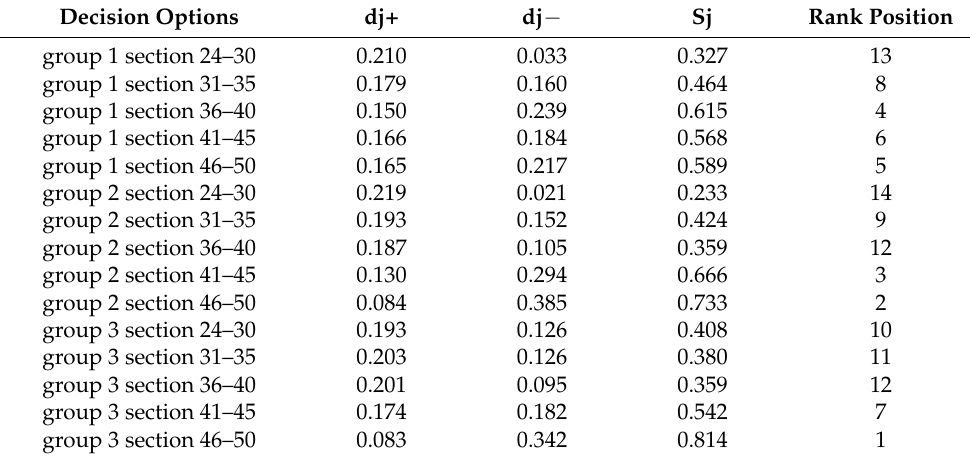
Table 4. FUZZY TOPSIS ranking. Source: own research.